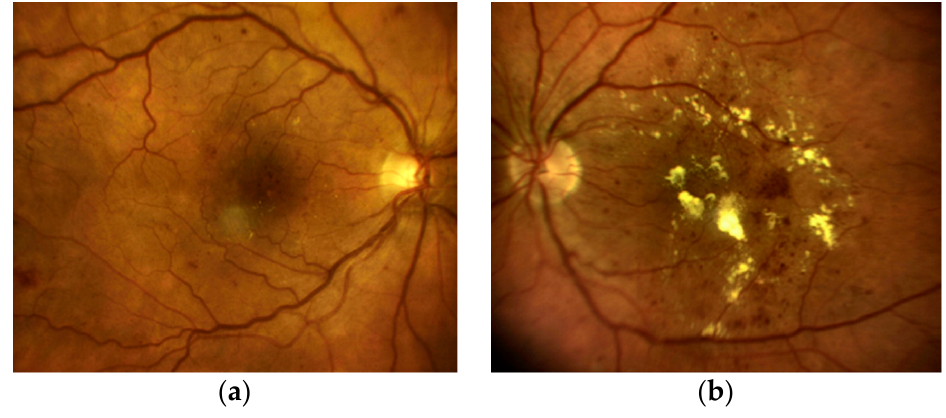
Figure 1. Fundus images: ( a ) healthy fundus; ( b ) fundus damaged by diabetic macular edema. The fundus has a three-dimensional structure. For this reason, flat image